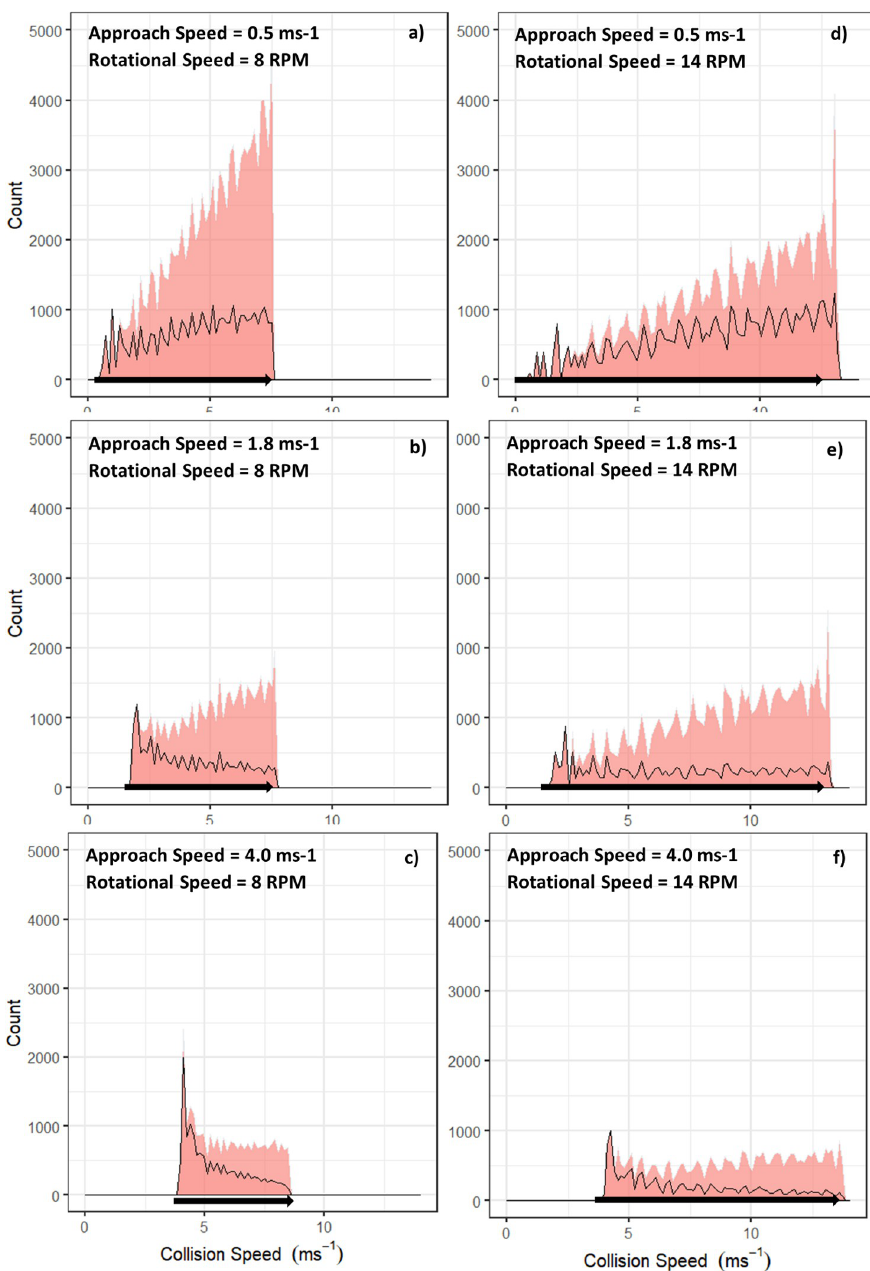
Fig 1. Area plots displaying the total number of collisions (area) and the number of times (count) varying collision speeds (ms -1 ) occurred. The area under the black line are collisions with the head and the area above are collisions with the torso of the animal. Each graph represents a different scenario with approach and rotational speeds displayed on the corresponding graphs and the black arrows on the x-axis represent how the speed of collision increases from the hub to the tip of the blade (tip of the